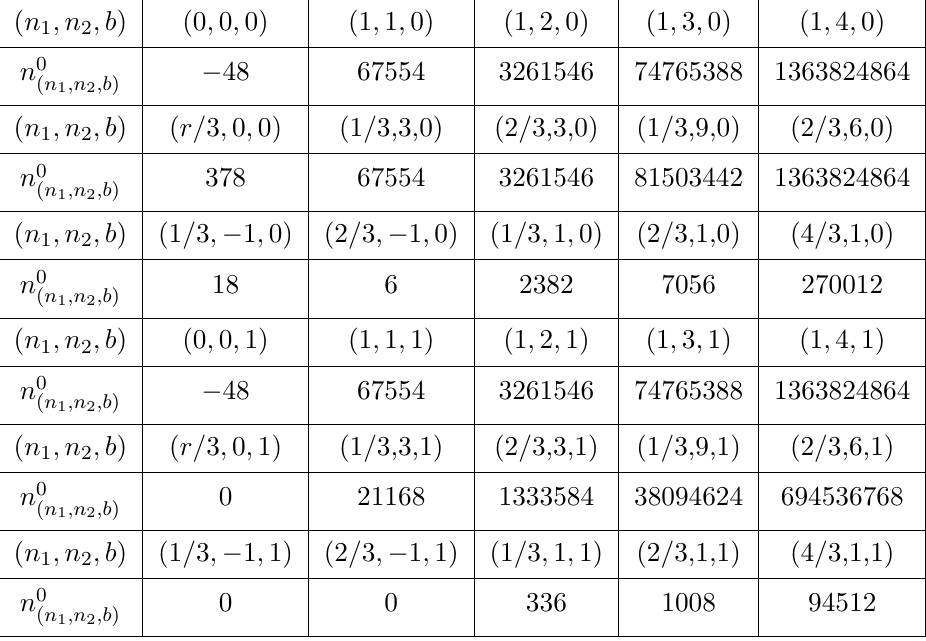
Table 5 . 3 A orbifold, standard embedding with single Wilson